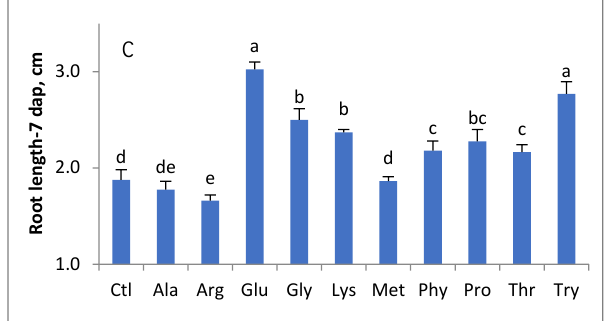
Figure 2. Effect of priming onion seeds with exogenous amino acids. ( A ) — Mean germination time, %; ( B ) — Vigor index, %; ( C ) — Radicle length, %. Ctl (Control); Ala (Alanine); Arg (Arginine); Glu (Glutamine); Gly (Glycine); Lys (Lysine); Met (Methionine); Phy (Phenylalanine); Pro (Proline); Thr (threonine); Try (tryptophan). Columns that share the same letter(s) are not statistically significant at p ≤ 0.01. The most extended root system (≥ 3.3 cm) was obtained when the onion seed was primed with Glu, Gly, Pro, and Try, while the shortest was observed at Ctl, Ala, and Arg treatments (≤ 2.2 cm).